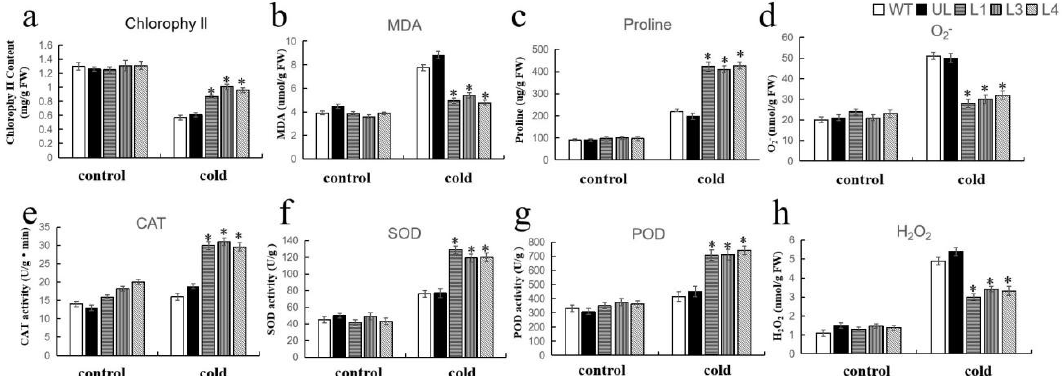
Figure 8. WT, UL transgenic A. thaliana lines (L1, L3, and L4) overexpressing FvMYB44 under cold treatment (−8 °C for 14 h) have the following physiological indicators. Chlorophyll ( a ), MDA ( b ), proline ( c ), O 2− ( d ), and ( h ) hydrogen peroxide (H 2 O 2 ) content, and ( e ) CAT, ( f ) SOD, and ( g ) POD activity. The transgenic lines (L1, L3, and L4), the UL, and the WT are distinguished from each other by asterisks above each error bar. (* p ≤ 0.05). The index level of WT was used as the study control group.